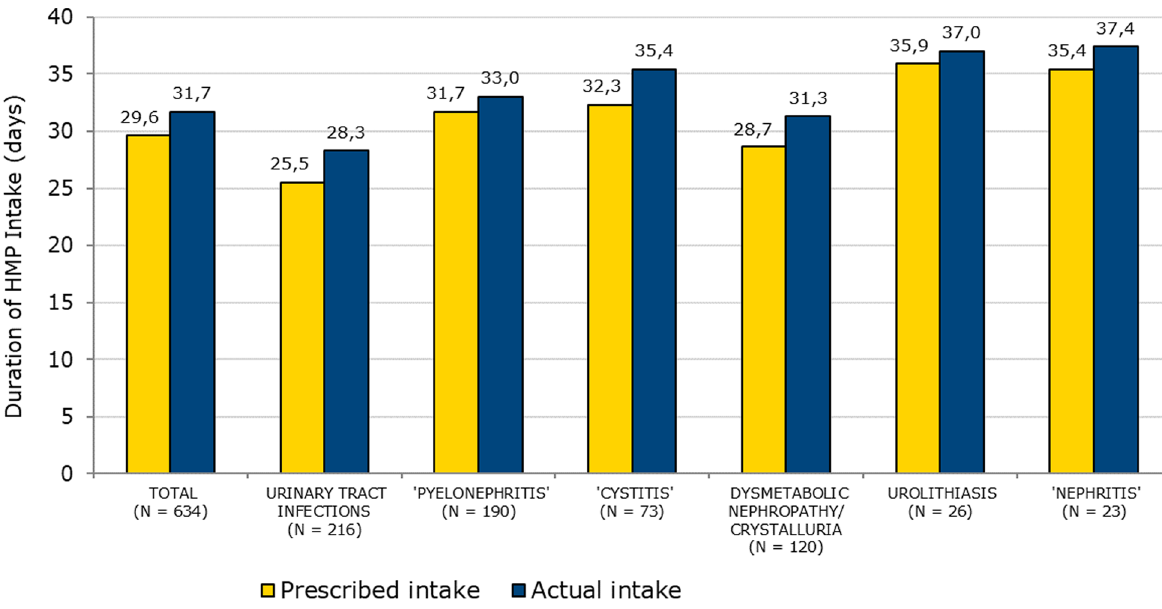
Fig. 5 Average treatment duration per indication group (Safety